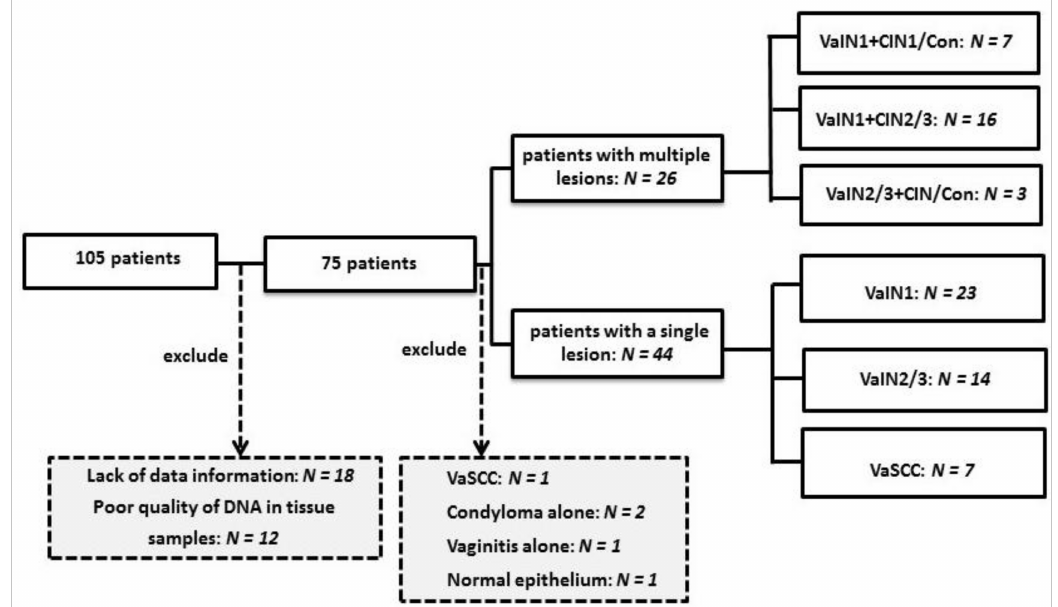
Figure 1. Stratification of patients investigated for vaginal squamous intraepithelial tissue lesions. CIN: cervical intraepithelial neoplasia; Con: condyloma; N : number; VaSCC: vaginal squamous cell carcinoma; VaIN: vaginal intraepithelial